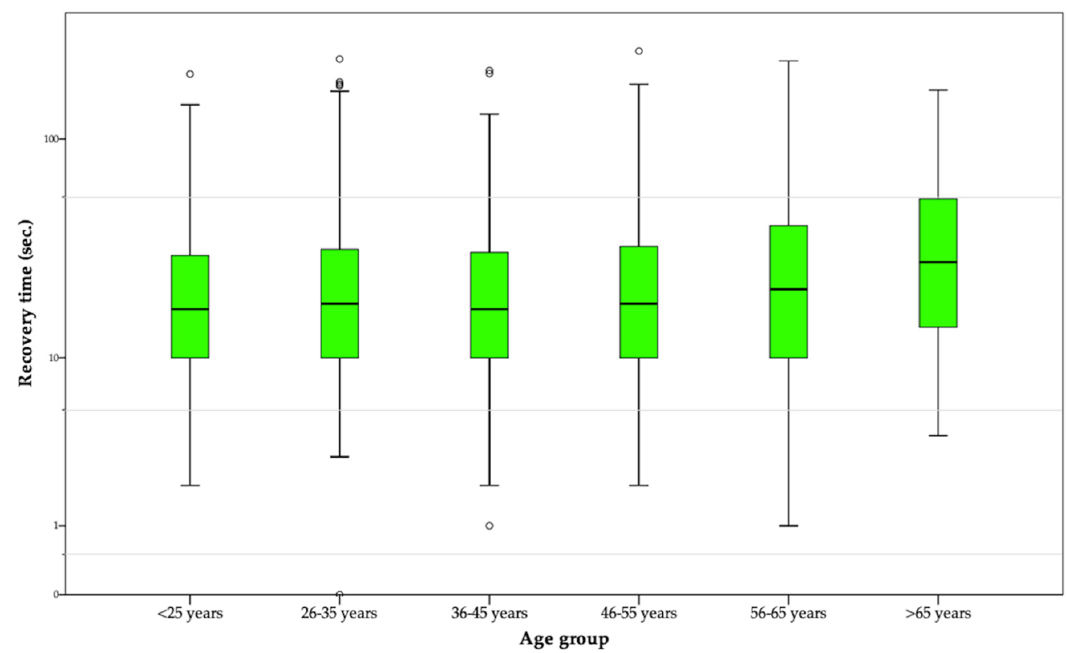
Figure 4. Boxplot—distribution of scores in full-vision recovery time after a 10-s exposition to glare, by age group (logarithmic / base-10 scale).